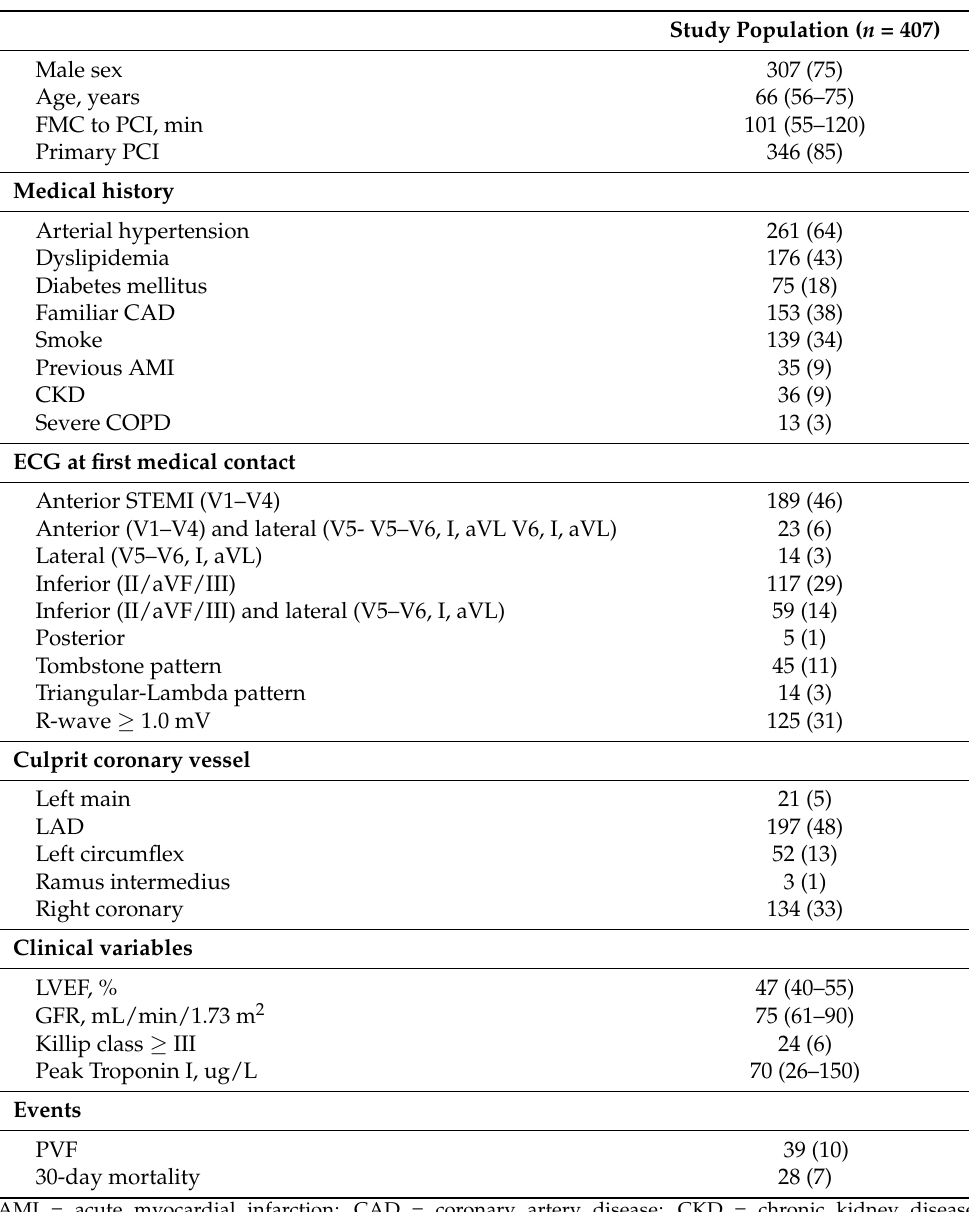
Table 1. Clinical and electrocardiographic features in the study population. Values are expressed as number of patients (%) or median [25 and 75%